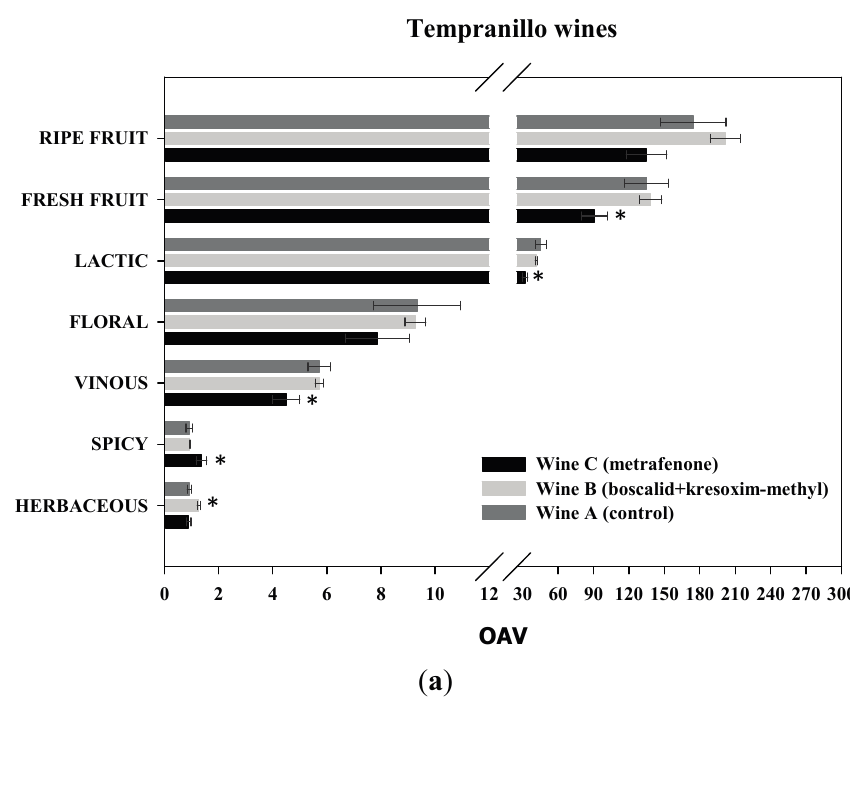
Figure 2. Aromatic profile of monovarietal red wines according to their odorant series: ( a ) Tempranillo-based wines and ( b ) Graciano-based wines. Significant differences at p < 0.05 (Fisher’s least significant difference test) with respect to control wines were pointed out with an asterisk